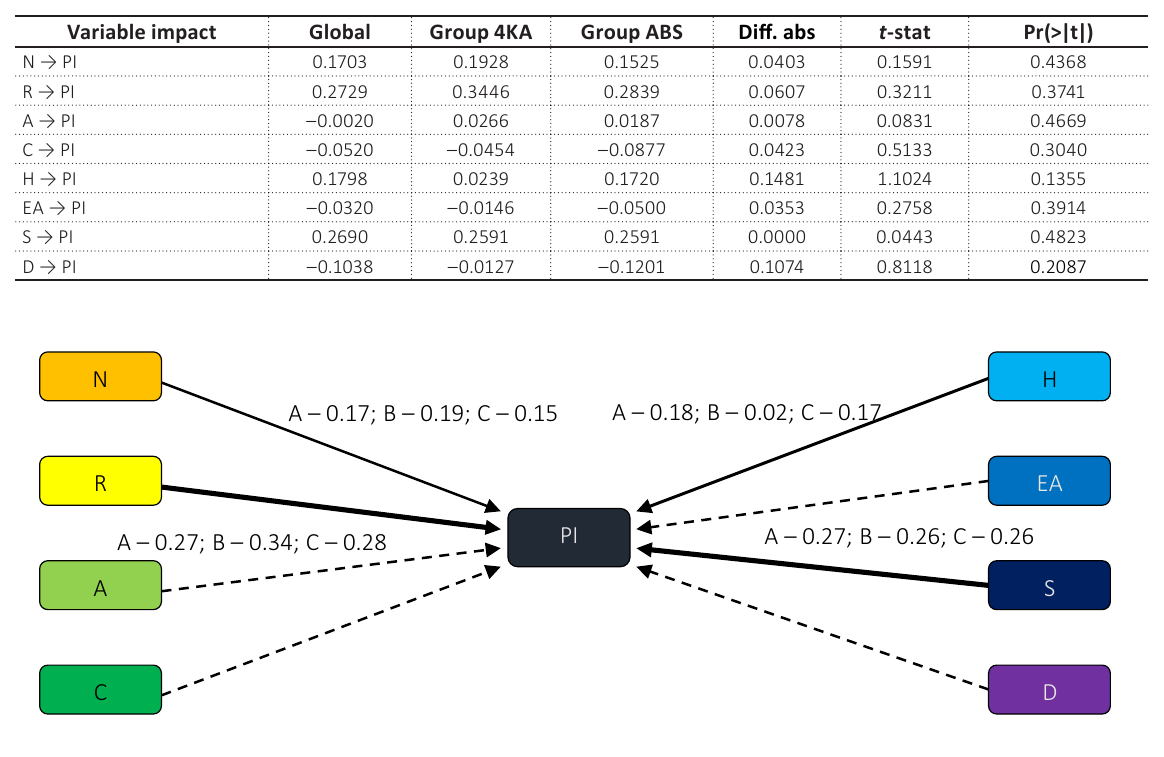
Table 8. PLS PM estimate differences test